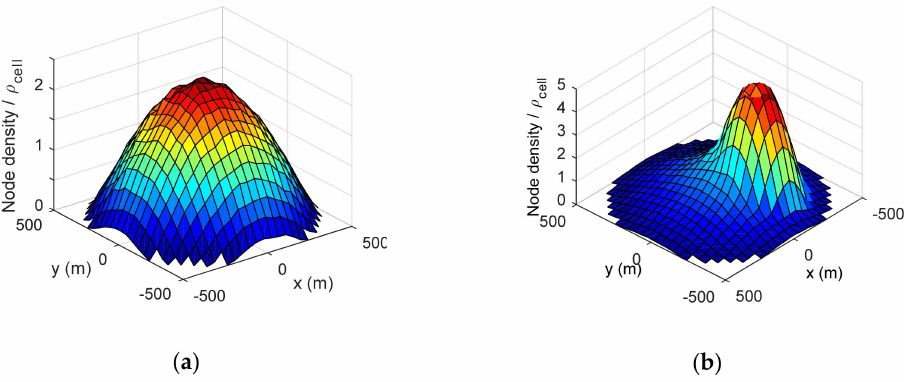
Figure 4. UE distribution as a function of the distance to the base station (BS) in di ff erent evaluation scenarios: ( a ) Circularly symmetric scenario; ( b ) Non-symmetric